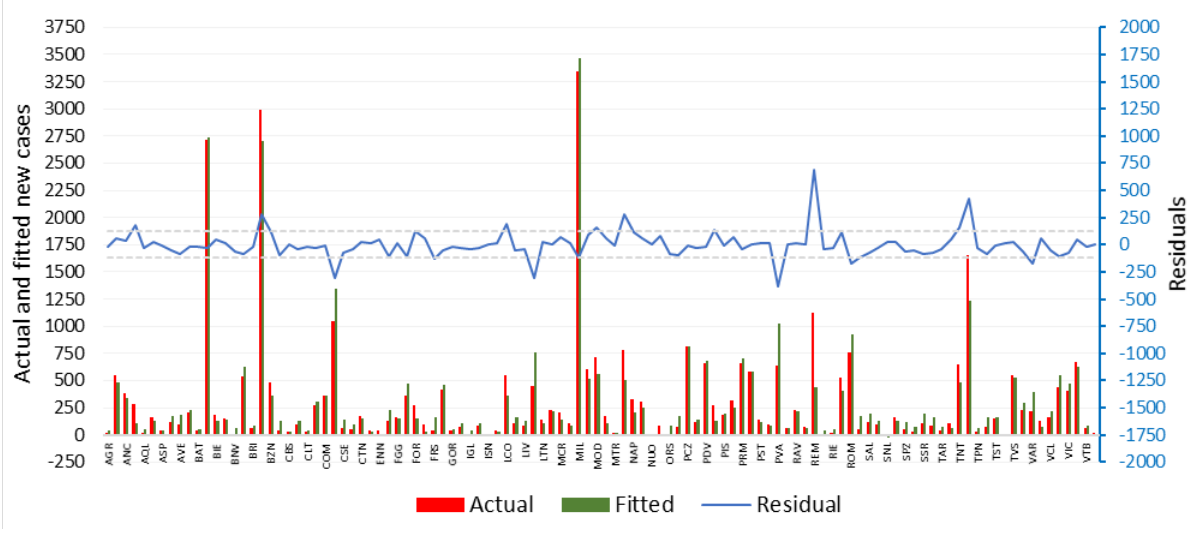
Figure 2. Figure 10. Residuals of colocation (Equation 11) model, week 12